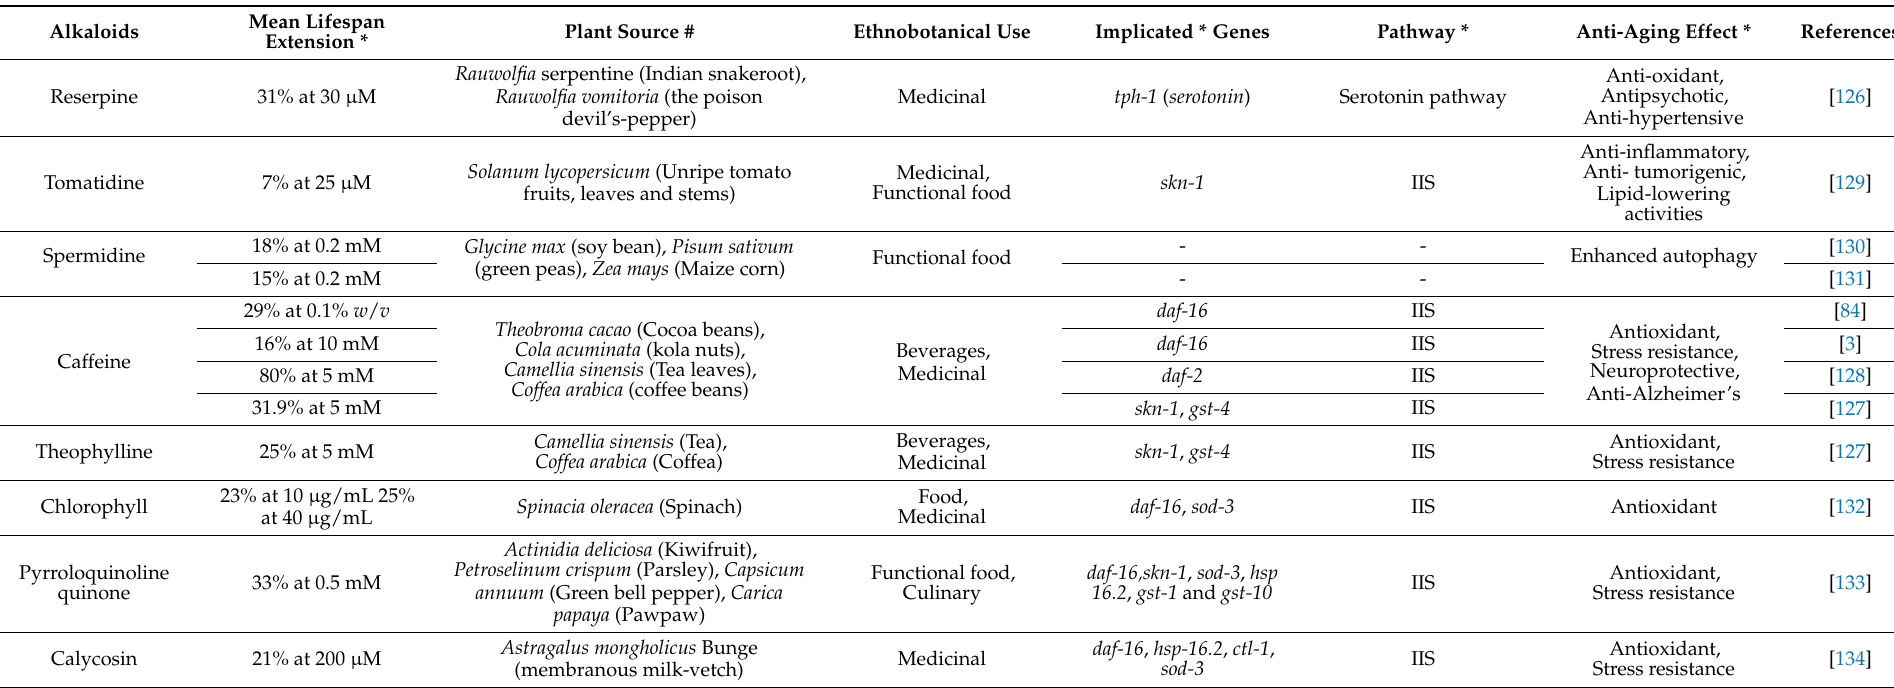
Table 3. Alkaloids with anti-aging and lifespan extending properties as demonstrated in the C. elegans